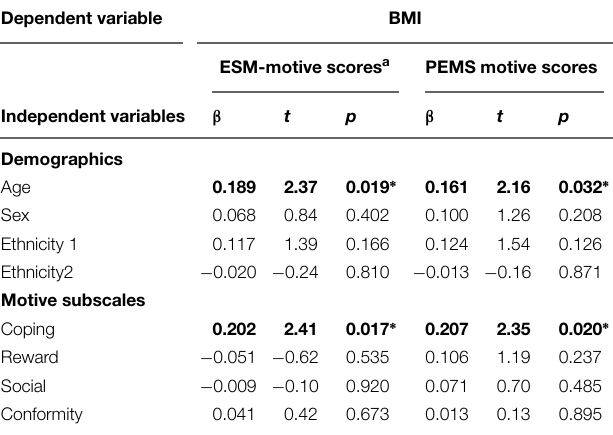
TABLE 3 | Linear regression models of the mean ESM-reported motive scores and PEMS scores with BMI as the dependent